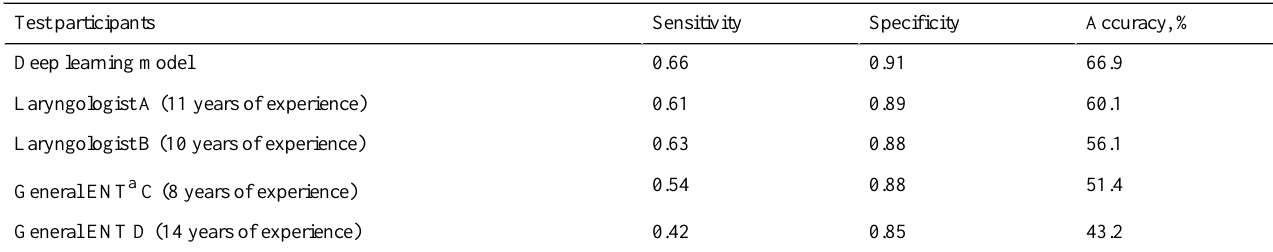
Table 3. Comparison of the performance for a 5-classification condition by our artificial intelligence model and 4 human